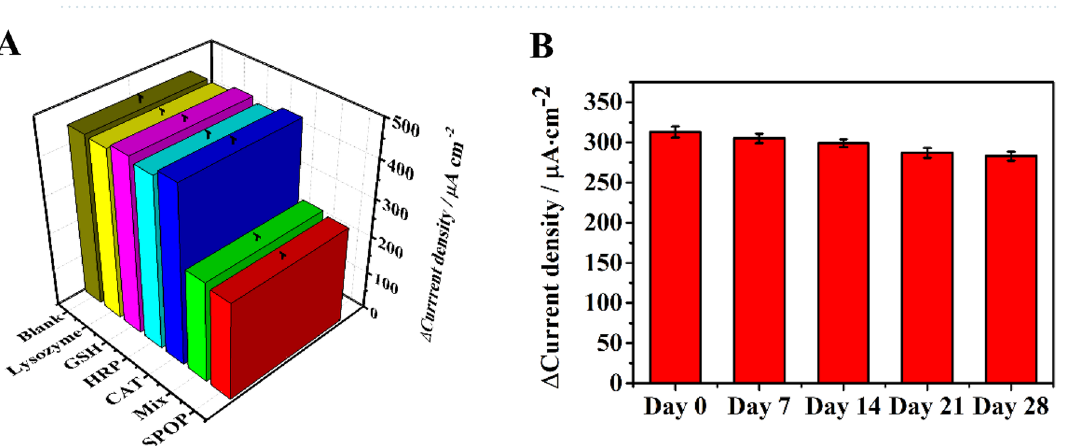
Figure 6. ( A ) Specificity of the immunosensor for SPOP (0.1 ng/mL), several competing 5 interfering substances (Lysozyme, GSH, HRP, CAT) (1 ng/mL), a mixture (Mix) of the interfering substances (1 ng/mL) and SPOP (0.1 ng mL −1 ) and zero analyte (Blank). ( B ) Stability of the immunosensor at 0 d, 7d, 14 d, 21 d, and 28 d. The concentration of SPOP was 10 pg mL −1